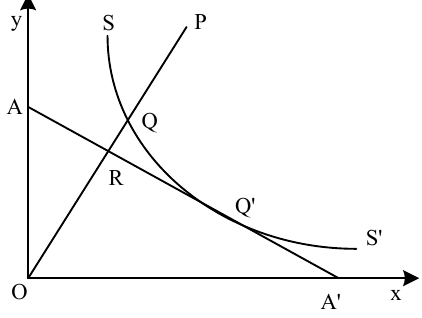
Figure 1. Technical efficiency and allocative efficiency of enterprises.